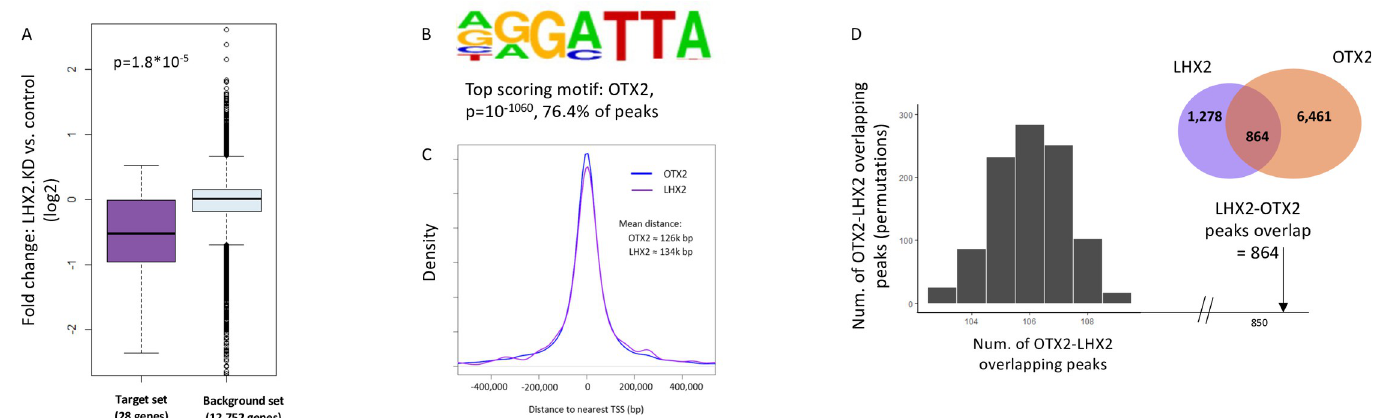
Fig 3. Shared direct targets of LHX2 and OTX2 in human RPE. (A) The set of putative Otx2 target genes, previously identified by expression analysis in Otx2-ablated mouse retina, is significantly down-regulated in RPE upon LHX2 KD. The expression analysis in Otx2-ablated retina detected a set of 52 down-regulated genes [14]. We were able to map 41 of these genes to a unique human orthologous gene. Of these, 28 genes were detected in our RNA-seq analysis of RPE cells. This set of 28 genes showed a significant reduction in gene expression in RPE cells knocked-down for LHX2 compared to control cells ( p -value calculated using Wilcoxon’s test). (B) The top- enriched motif detected by de novo motif analysis on the OTX2 ChIP-seq peaks corresponds to the known OTX2-binding motif. (C) Location distribution of LHX2 and OTX2-binding sites with respect to their nearest TSS. Both TFs show a broad distribution where 50% of the peaks are located > 40 kbp from their nearest gene. (D) The observed overlap between LHX2 and OTX2-binding sites (864 overlapping sites) is highly significant, as demonstrated by 1,000 permutations tests in which the average overlap was 105 sites. KD, knockdown; RPE, retinal pigmented epithelium; TF, transcription factor; TSS, transcription start